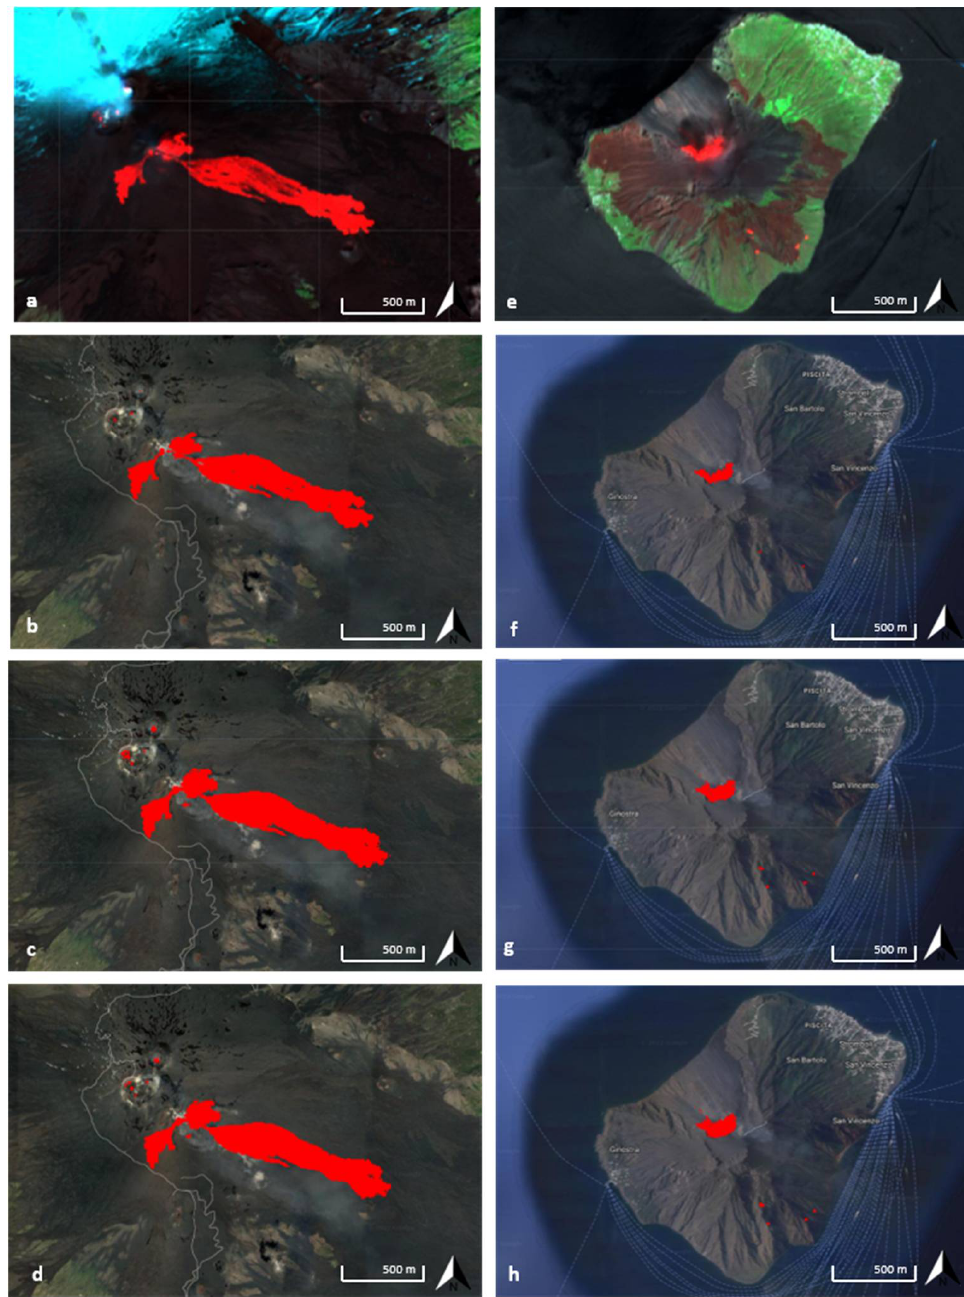
Figure 4. Feature importance related to the models RF1 ( a ) and RF2 ( b ).